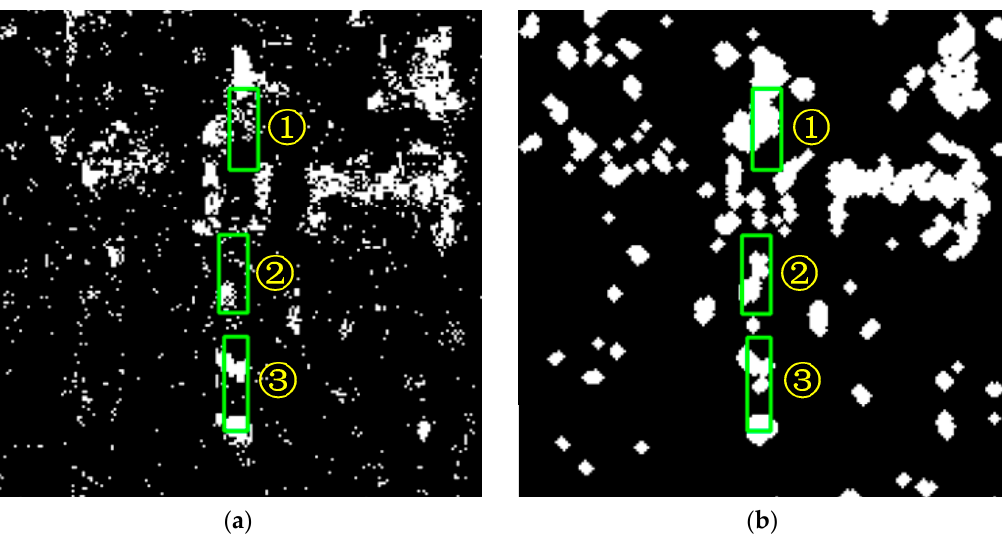
Figure 10. Comparison between the multi-interval frame difference algorithm and the conventional frame difference algorithm. The green rectangles represent the real position of the shadow of the moving target. ( a ) Result of conventional frame difference. ( b ) Result of multi-interval frame difference.